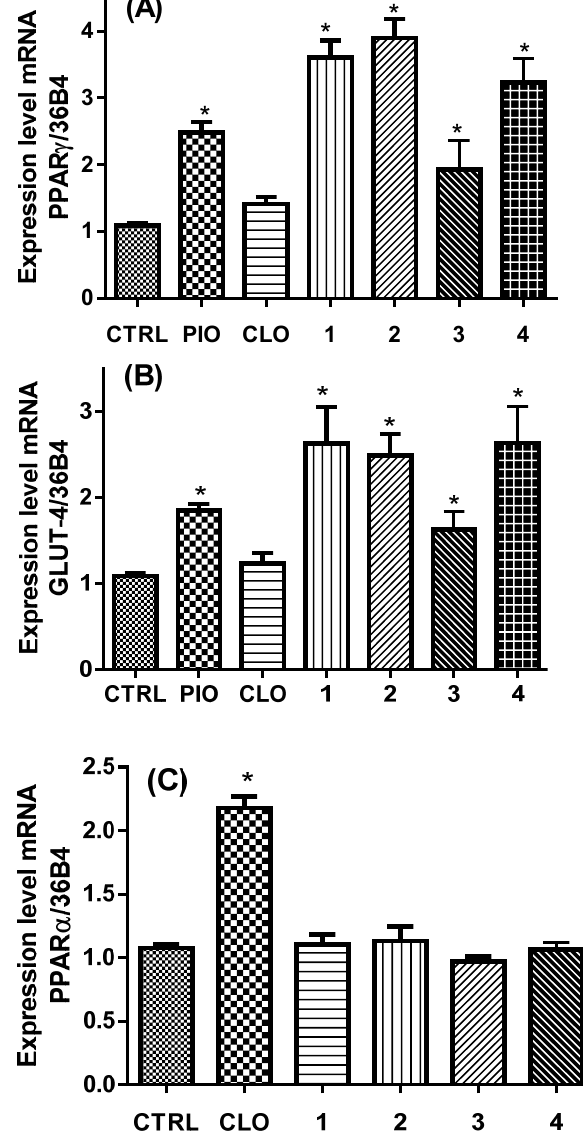
Figure 3. Changes on the expression of PPAR γ ( A ), GLUT-4 ( B ), and PPAR α ( C ) genes induced by pioglitazone, clofibrate, and isobutyric acid derivatives 1–4 . * Statistically significant difference between control group and test samples were estimated using ANOVA with post hoc Dunnett’s test ( n = 5, mean ± SEM, p < 0.001 compared with CTRL group).